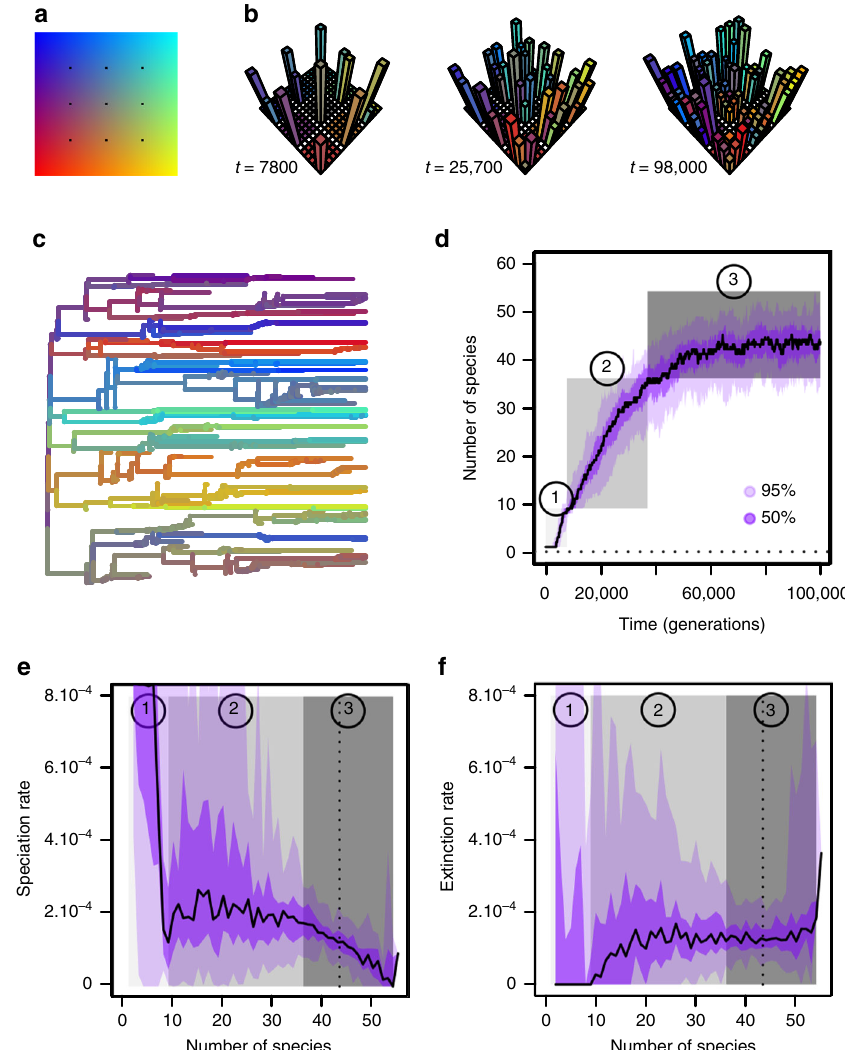
Fig. 1 Macroevolutionary dynamics in silico. a , b Example of diversi fi cation in space and time. Color-coded phenotypes vary continuously across a two- dimensional phenotypic space ( a ); black dots indicate the phenotypic optimum in each of the nine geographic sites. Panel b shows the populations (vertical bars, height measures abundance, and color indicates phenotype) of all species at three different times ( t ), across the nine geographical sites into which the landscape (horizontal plane) is subdivided. The color of each site indicates the corresponding phenotypic optimum. c Phylogenetic tree of extant and extinct species, with colors showing the average phenotype along each branch. d Species diversity through time, measured in the number of generations from the common ancestor ’ s introduction in the landscape. e Speciation rate as a function of diversity. f Extinction rate as a function of diversity. In d – f black lines give median values over 50 simulation replicates, purple areas give 95% (dark purple) and 50% (light purple) con fi dence intervals, and the three stages of diversi fi cation (1 – 3) are highlighted by gray shadings. Parameter values as in Supplementary Table